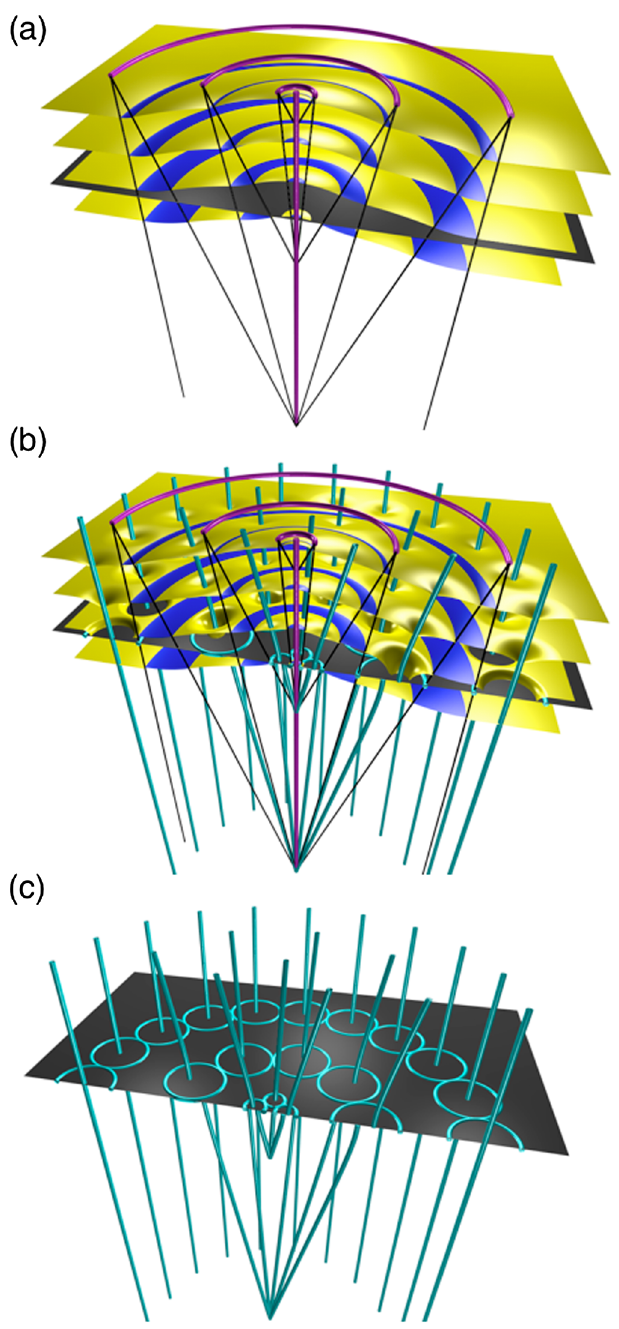
FIG. 4. Flower texture in the LCC. (a) Background texture approximating a curved homeotropic interface and its paral- lel layers by alternating TFCDs (blue) and concentric spheres or planes (yellow). TFCD focal curves are in ma- genta. The gray plane, arbitrarily placed, schematically represents the degenerate planar interface, below which there is no smectic physically. (b) FCDs of radially varying eccentricity punctuate the concentric spherical and planar regions. The focal curves of these FCDs are shown in cyan. Focal hyperbolæ are physical above the substrate and virtual below. (c) The focal curves of the smectic flower geometry in